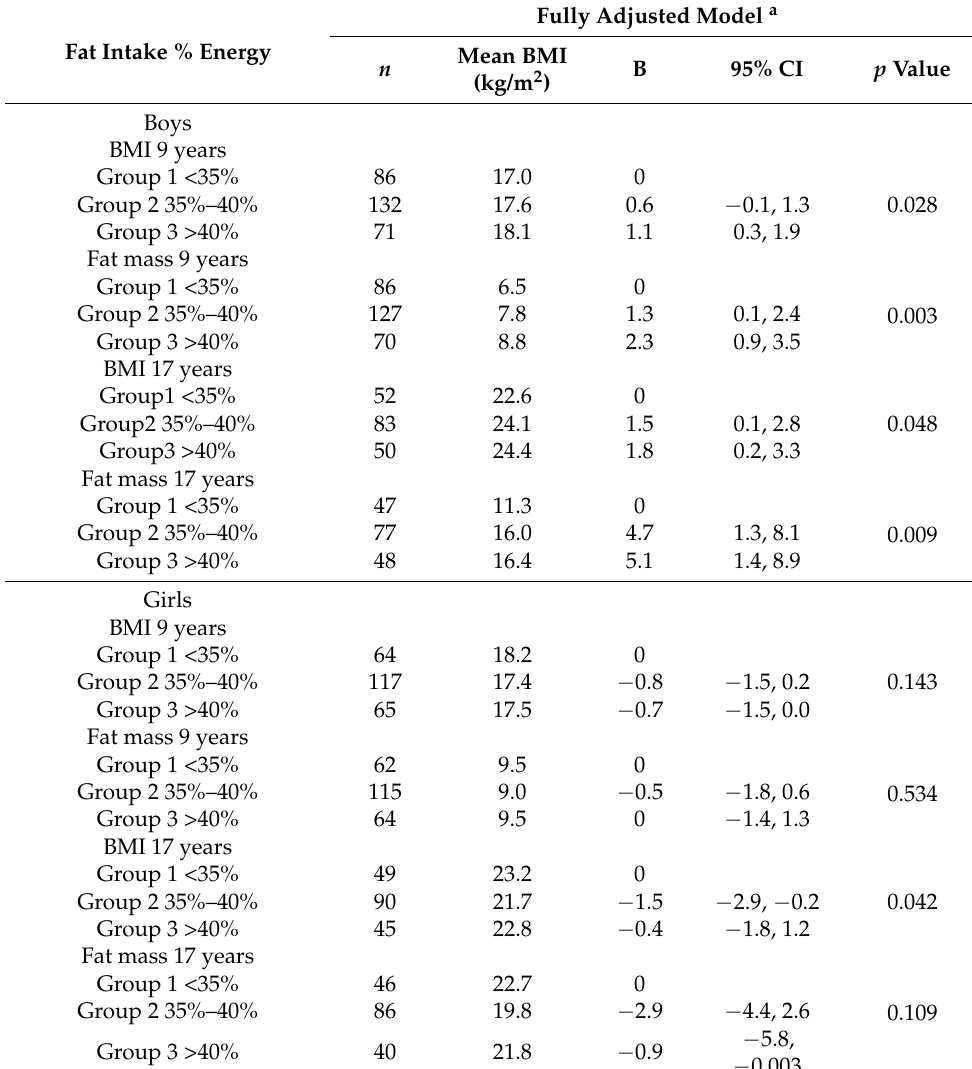
Table 6. Multiple linear regression models for energy—adjusted fat intakes of boys and girls (classi- fied into groups according to international guidelines [18]), using diet collected at 18 months of age to predict body composition at 9 and 17 years of age in children enrolled in ALSPAC-CiF. Fully Adjusted Model a Fat Intake % Energy Mean n